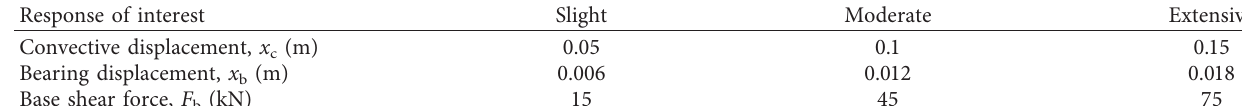
Table 4: Limit states for fragility assessment of tank.